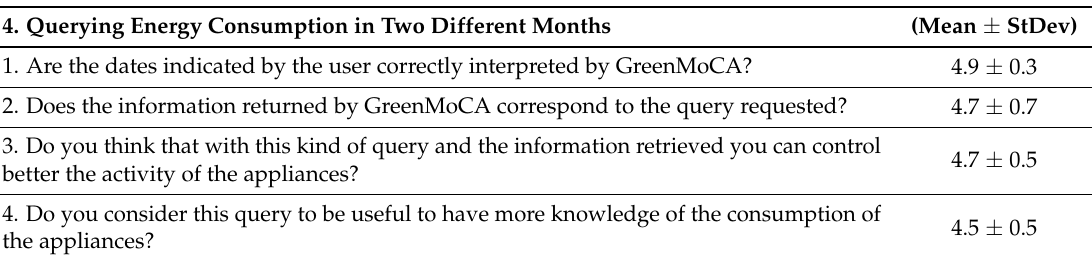
Table 4. Mean and Standard Deviation for the scores in the questions/statements of task